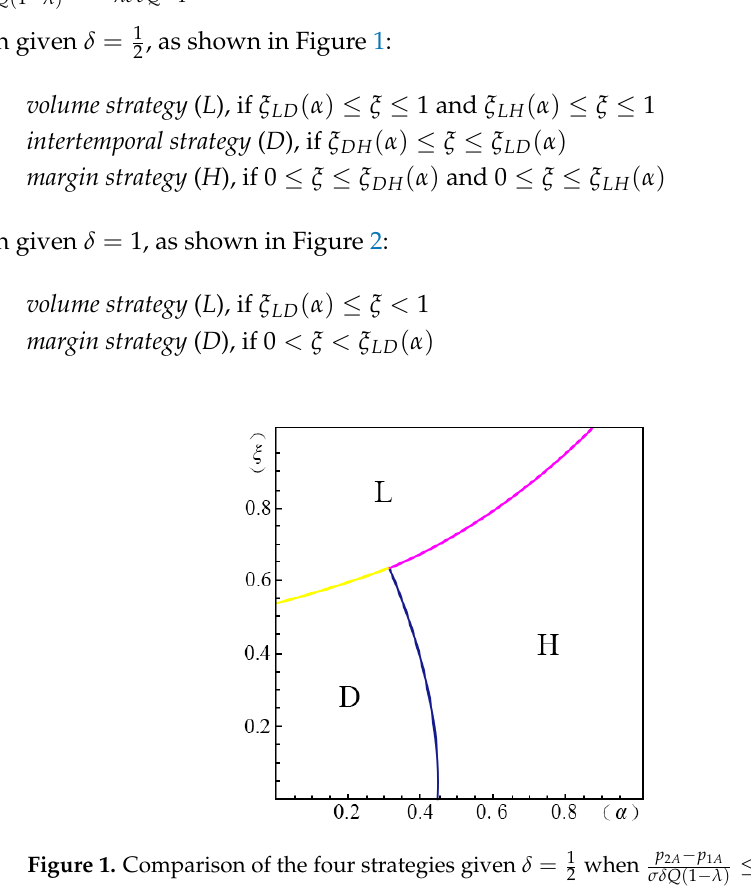
Figure 2. Comparison of the four strategies given (cid:2012) (cid:3404) 1 when (cid:3043) (cid:3118)(cid:3250) (cid:2879)(cid:3043) (cid:3117)(cid:3250) (cid:3097)(cid:3083)(cid:3018)(cid:4666)(cid:2869)(cid:2879)(cid:3090)(cid:4667) (cid:3409) (cid:3043) (cid:3117)(cid:3250) (cid:3397)(cid:1863)(cid:1859) (cid:2879)(cid:3043) (cid:3090)(cid:3097)(cid:3083)(cid:3018)(cid:2879)(cid:2869) . In case of (cid:2012) (cid:3404) (cid:2869) (cid:2870) , shown in Figure 1, menu pricing ( M ) has no advantages. When the fraction of high ‐ type consumers ( (cid:2009) ) is low and the gap between high and low valuations ( (cid:2869) (cid:3093) ) is large, the intertemporal strategy ( D ) can enable the creator to earn maximum profits. On the contrary, it is wise to choose the margin strategy ( H ) when the fraction of high ‐ type consumers is large. When the gap between the high and low valuations of consumers ( (cid:2869) (cid:3093) ) is small, then the volume strategy ( L ) is the most applicable. In Figure 2, we can also find that when (cid:2012) (cid:3404) 1 , (i.e., when the green crowdfunding product is able to be substituted by its substitute in functions or appearance), only the volume strategy ( L ) and intertemporal strategy ( D ) are applicable. When the gap between the high and low valuations is large, the intertemporal strategy ( D ) is the optimal strategy. In the opposite case, the volume strategy ( L ) is more applicable. (ii) If (cid:3043) (cid:3118)(cid:3250) (cid:2879)(cid:3043) (cid:3117)(cid:3250) (cid:3097)(cid:3083)(cid:3018)(cid:4666)(cid:2869)(cid:2879)(cid:3090)(cid:4667) (cid:3408) (cid:3043) (cid:3117)(cid:3250) (cid:2878)(cid:3038)(cid:3034)(cid:2879)(cid:3043) (cid:3090)(cid:3097)(cid:3083)(cid:3018)(cid:2879)(cid:2869) , as show in Figure 3, (a) volume strategy ( L ), if (cid:2022) (cid:3013)(cid:3005) (cid:4666)(cid:2009)(cid:4667) (cid:3409) (cid:2022) (cid:3407) 1 (b) intertemporal strategy ( D ), if 0 (cid:3407) (cid:2022) (cid:3407) (cid:2022) (cid:3013)(cid:3005) (cid:4666)(cid:2009)(cid:4667)